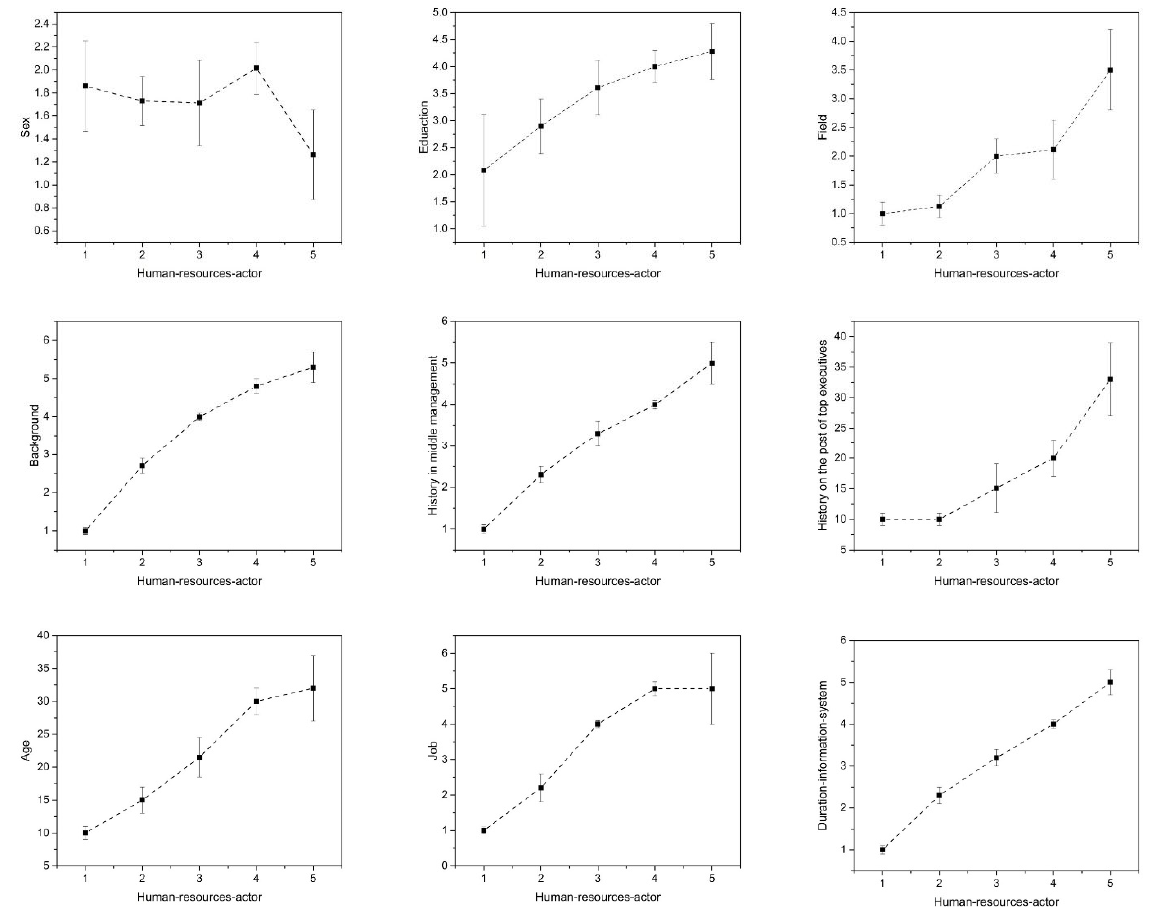
Figure 4. The Graph curvatures of various evaluated features vs. human actors.